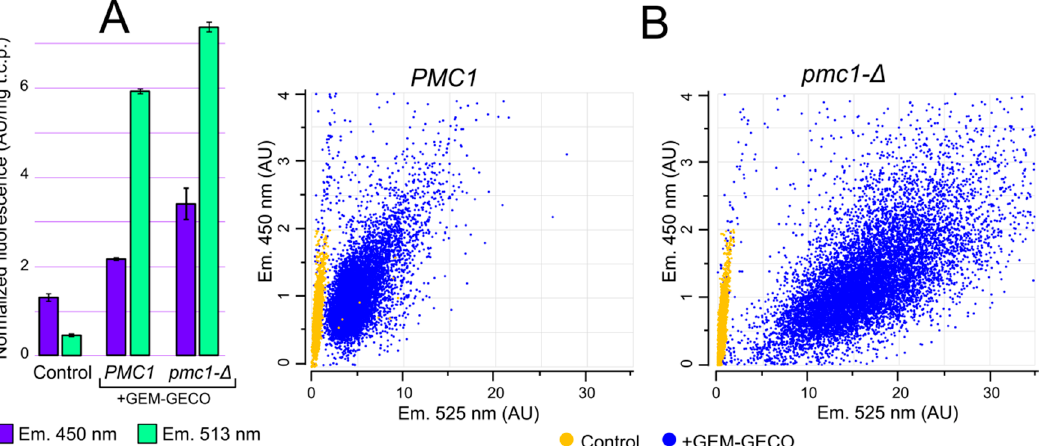
Figure 3. Comparison of fluorescence characteristics of cells with (+GEM-GECO) and without (Control) the GEM-GECO expression cassette. ( A ), Fluorescence normalized to the total cell protein in the cell suspensions of DL1-LC (Control), DL5-LC ( PMC1 ) and DL5-pmc1-LC ( pmc1- Δ ) strains. The fluorescence was excited by 395 nm light. ( B ), Flowcytometric analysis of cell fluorescence of strains: DL1-LC (Control, PMC1 ), DL1-pmc1-LC (Control, pmc1- Δ ), DL5-LC ( PMC1 ) and DL5-pmc1-LC ( pmc1- Δ ) strains (450 nm and 525 nm emission, 405 nm excitation).